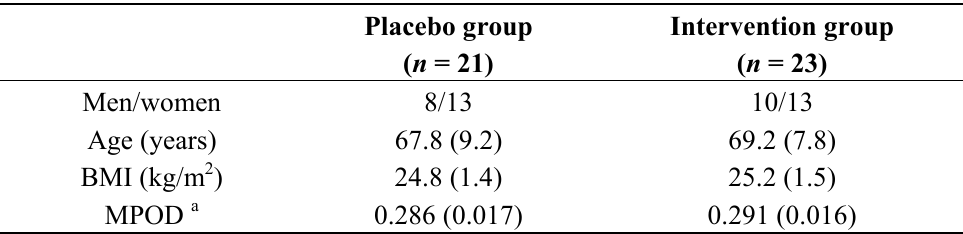
Table 1. General Parameters and basal macular pigment ocular density (MPOD) in age macular degeneration (AMD) patients with placebo and supplementation with lutein and docosahexaenoic acid